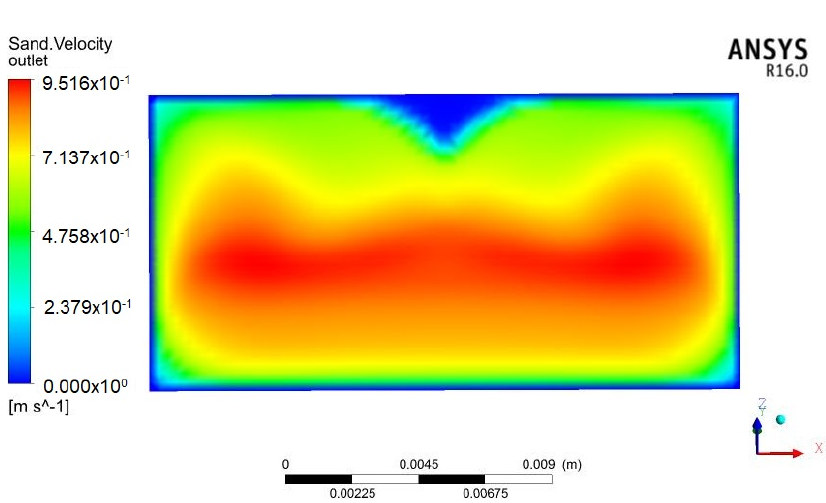
Figure 9. Sand velocity at the outlet.